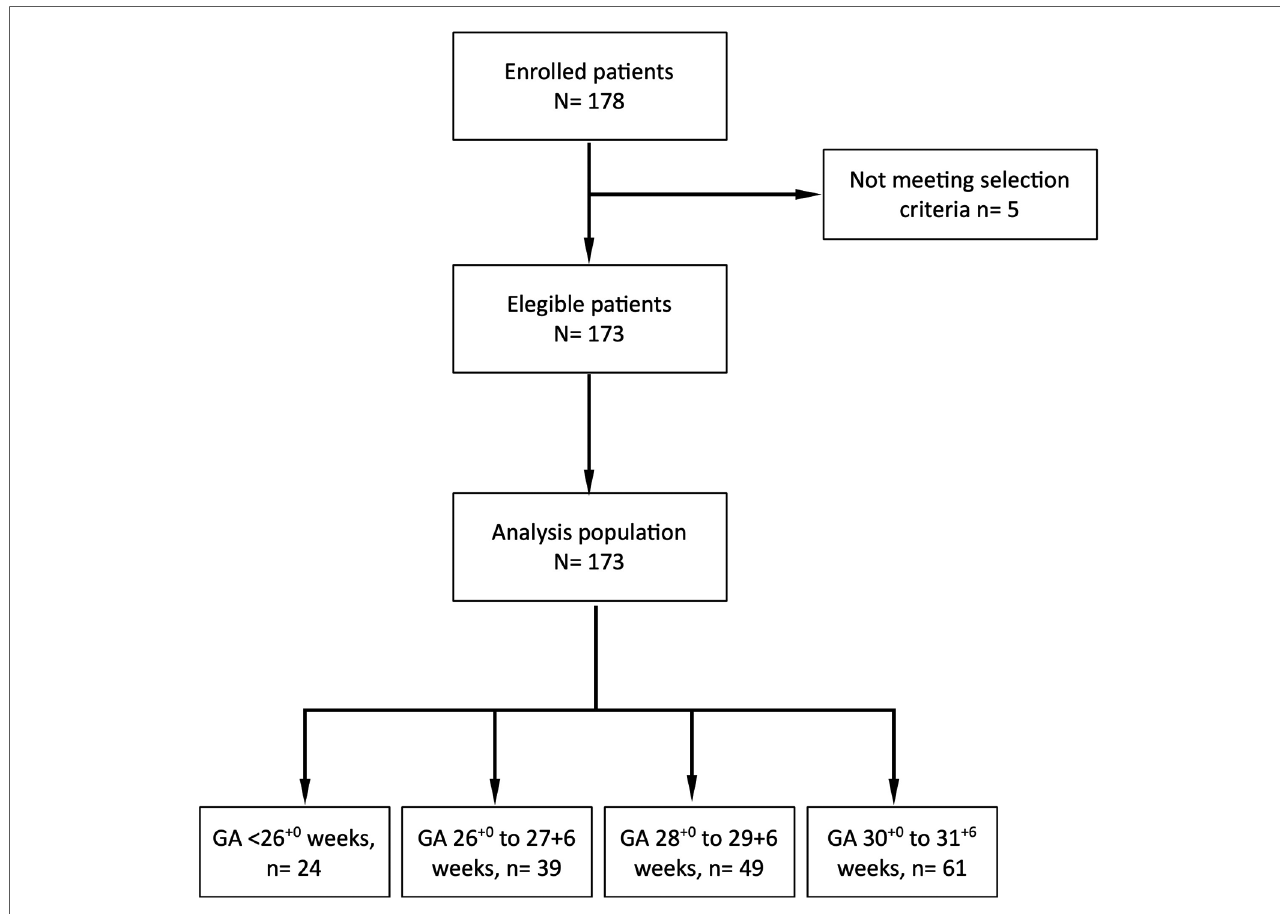
FIGURE 1 Patient distribution in the VENTIS study. GA, gestational